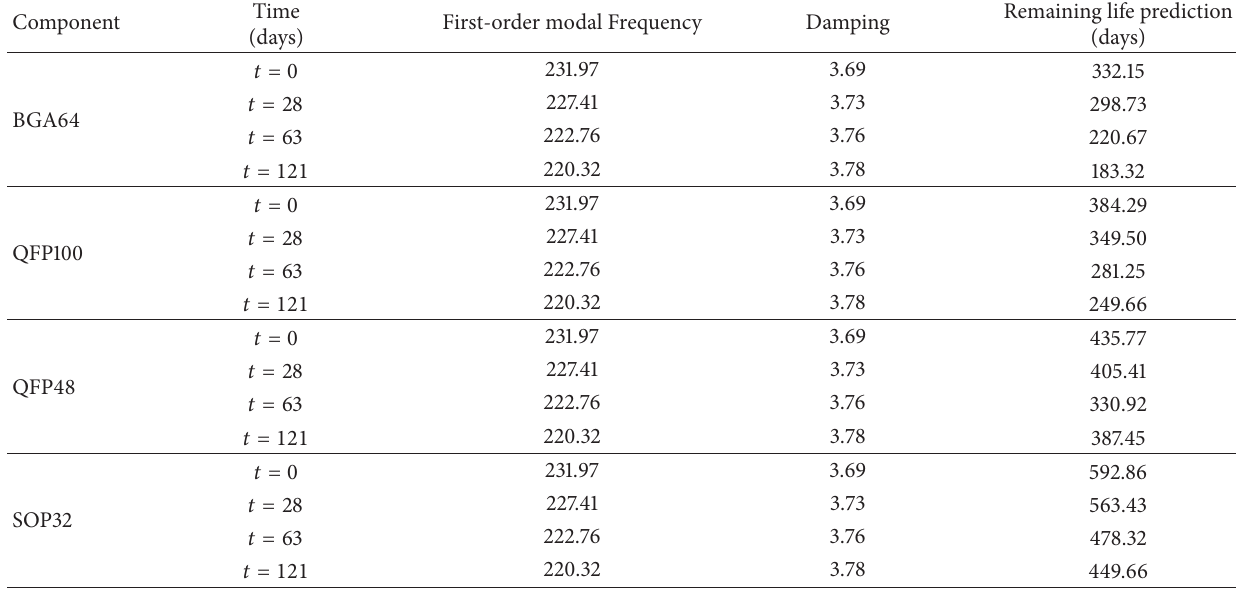
Table 1: Remaining life prediction